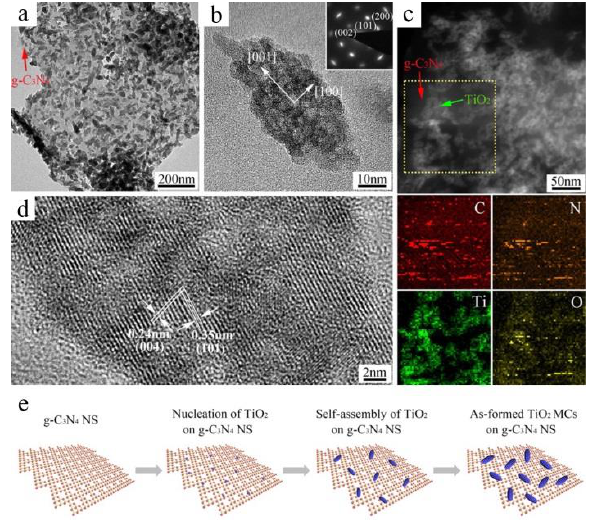
Figure 14. ( a , b ) TEM and ( c ) HRTEM images of 33.3% g-C 3 N 4 / DTMCs. The inset is the SAED pattern related to the whole particle. ( d ) HAADF-TEM image with elemental mapping of 33.3% g-C 3 N 4 / DTMCs. ( e ) Schematic presentation of the in situ growth of TiO 2 mesocrystals on a g-C 3 N 4 nanosheet. Reprinted with permission from [183]. Copyright John Wiley & Sons Inc., 2018.